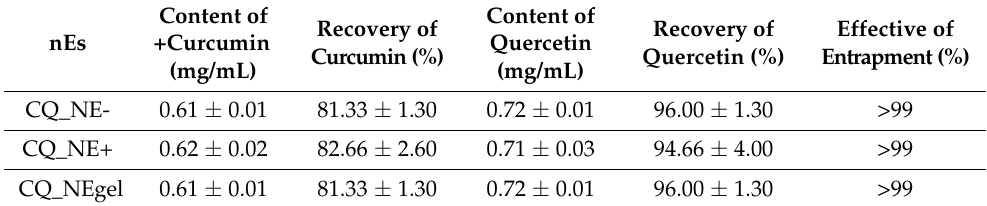
Table 3. Drug content, recovery, and effectiveness of entrapment [52].